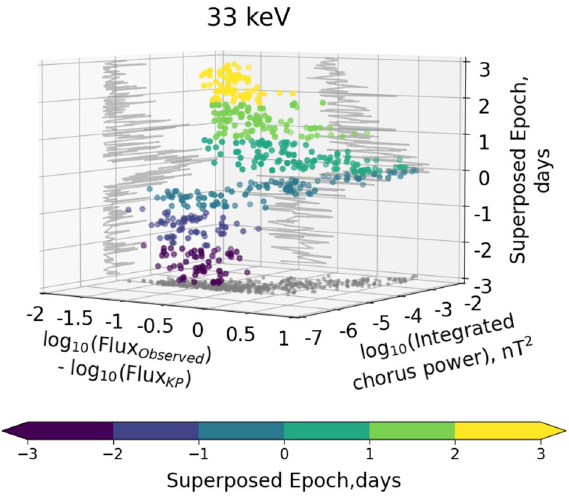
Figure 7. Scatter plot of the median integrated chorus wave power (in nT 2 ) and ratio of observed and KP limited flux (log scale) of 33 keV electrons in the L* range 4–5, as a function of superposed epoch (in days) in a three dimensional space (dots show the data, with the colour scale indicating the superposed epoch time - right axis). Projections onto the respective two dimensional planes are plotted in gray. The colorbar denotes the superposed epoch in